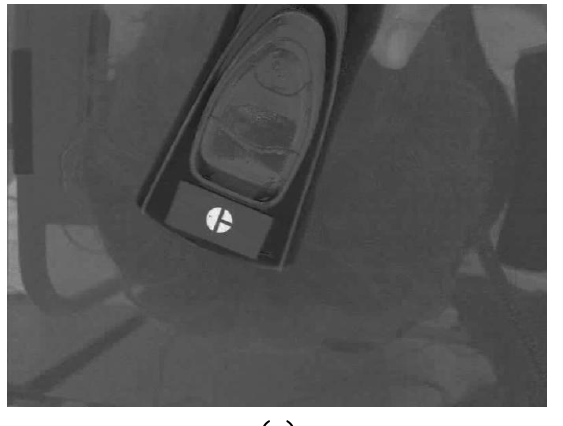
Figure 7. Color marker in the I image and its detection. ( a ) Red-colored marker in the I image. ( b ) Detection of marker by sub-block difference-based